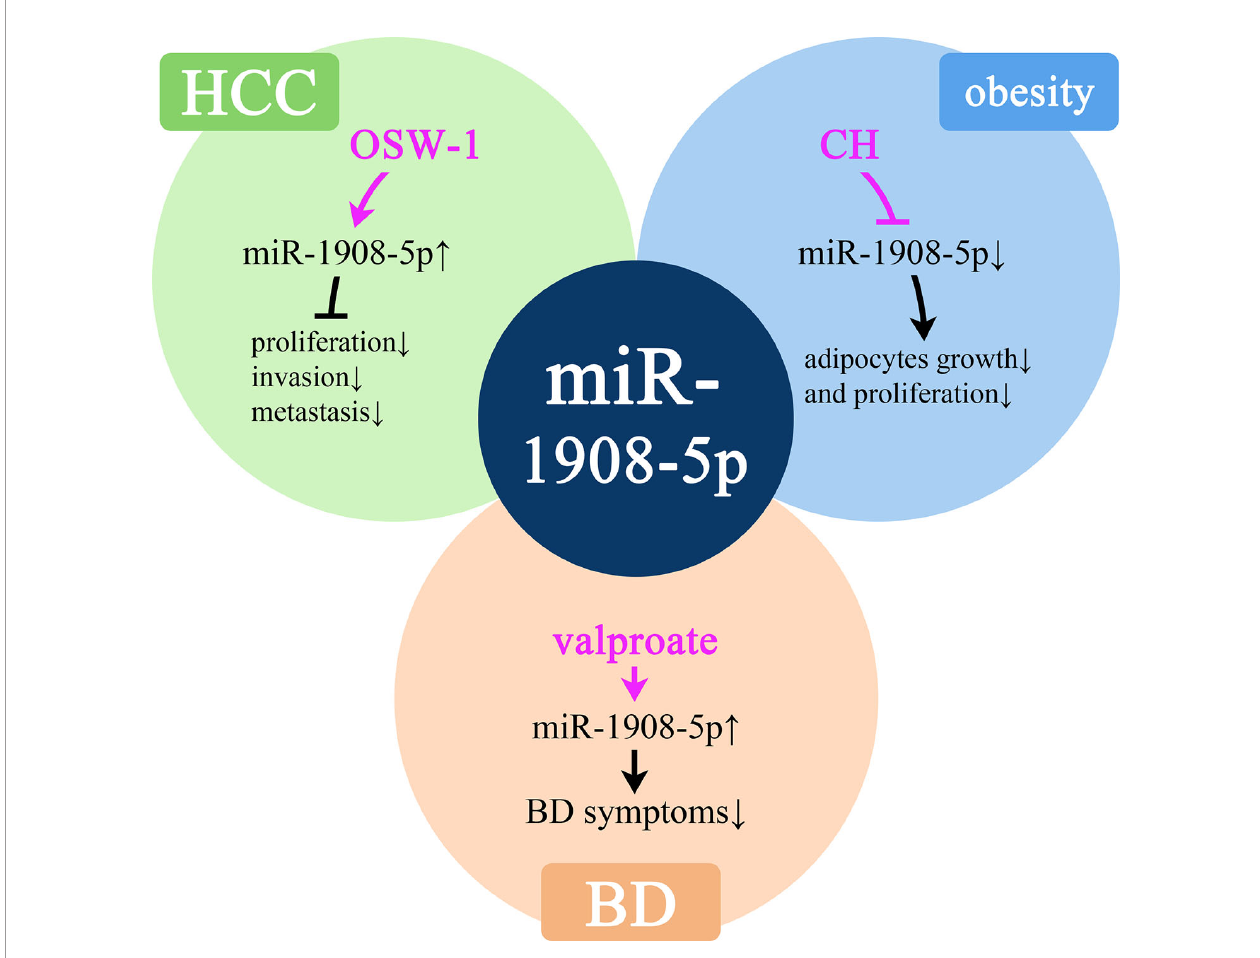
FIGURE 7 | Molecular mechanisms of potential drugs that can modulate miR-1908-5p. HCC, hepatocellular carcinoma; BD, bipolar disorder.